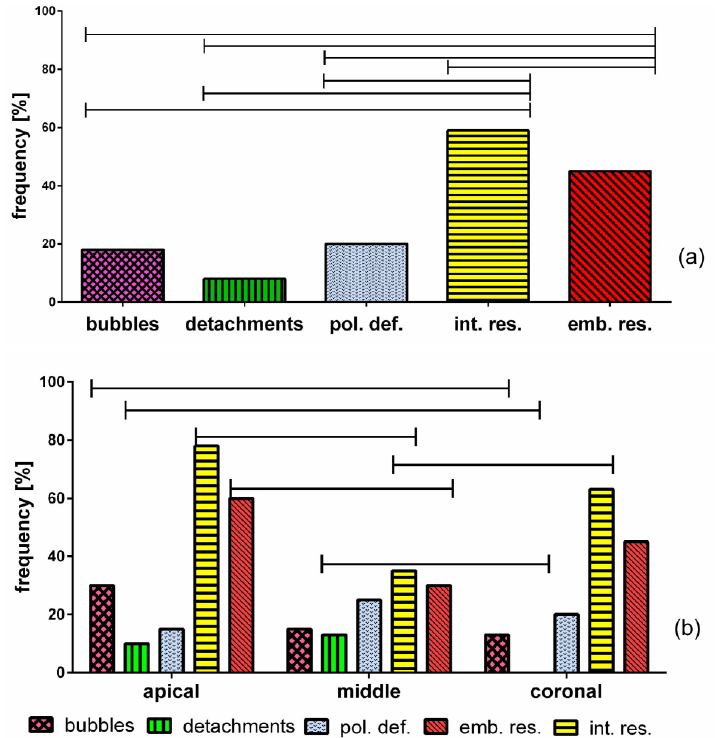
Figure 3. Frequency of defects taking all the sections together (regardless of either single specific level and irrigant/sealer combination) ( a ) and frequency of different defects in the three levels of the root (neglecting only the irrigant/sealer combination) ( b ). (pol.def = polymerization defects; int.res = endodontic cement residues at the dual cement-dentin interface; emb.res = embedded residues of endodontic cement into the dual cement